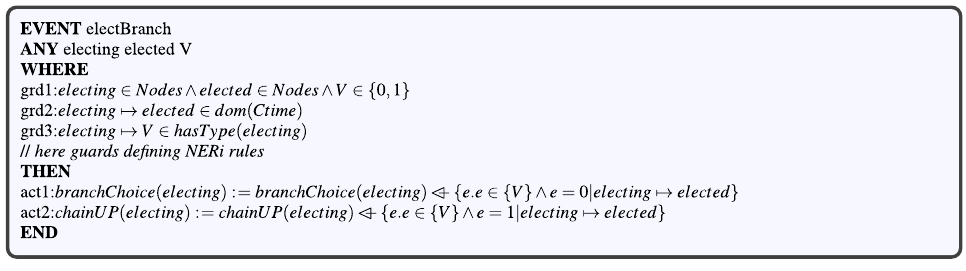
Figure 10. Branch election